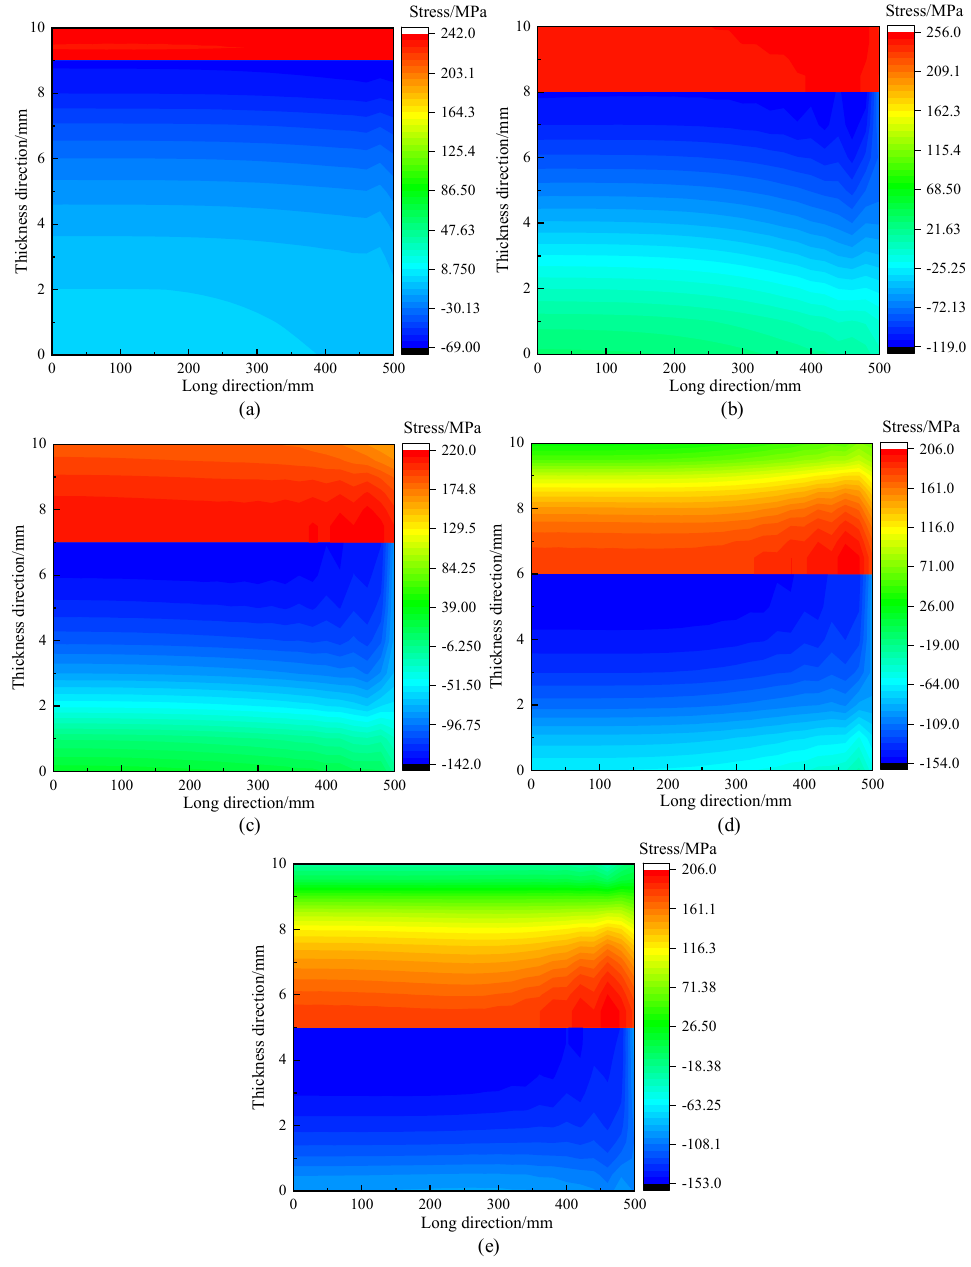
Figure 22. The residual stress distribution of 316L/Q235B composite plate under different composite ratio parameters. ( a ) 1/10; ( b ) 2/10; ( c ) 3/10; ( d ) 4/10; ( e ) 5/10.